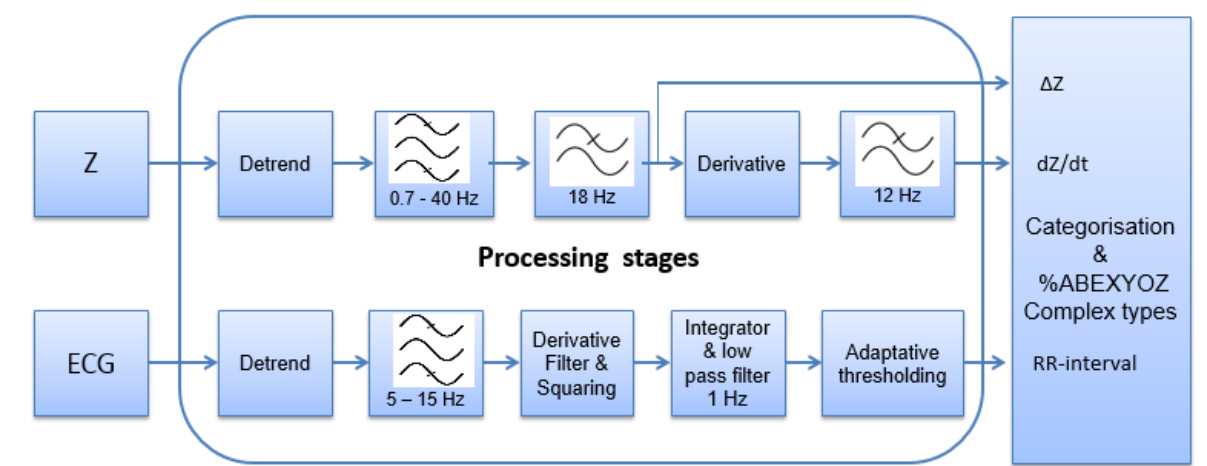
Fig. 3: Flowchart of the data processing